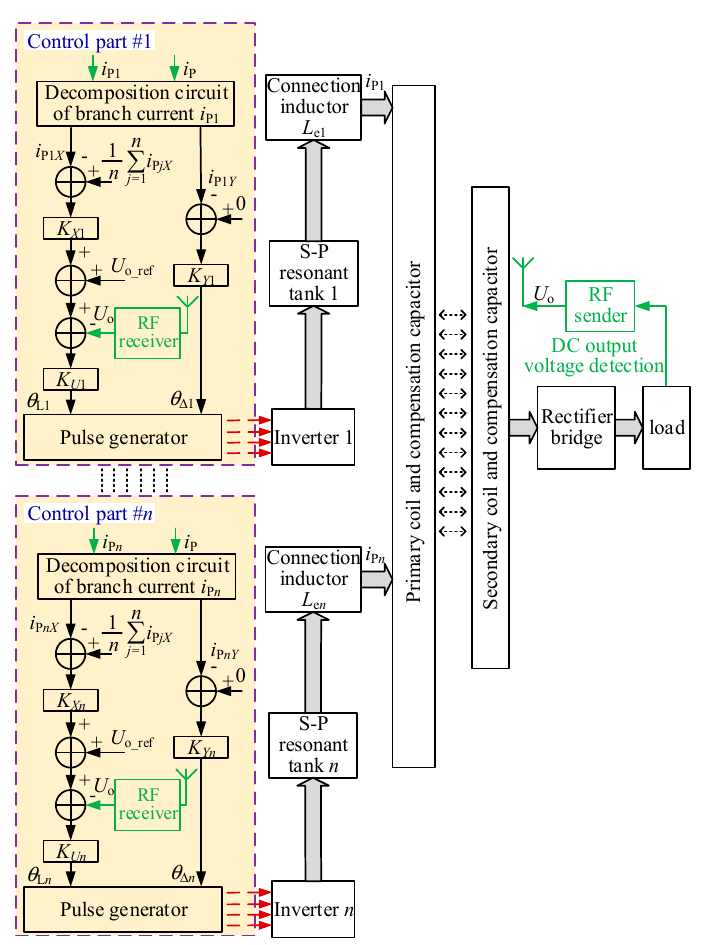
Figure 8. The control block diagram.